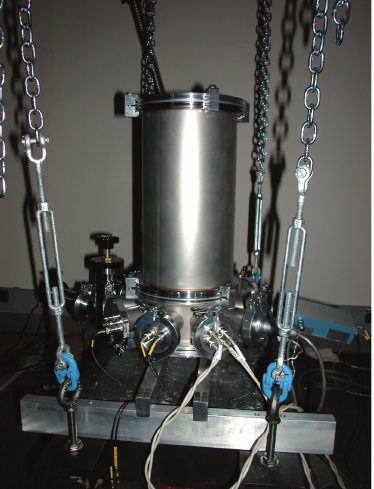
Figure 12: Scanning tunneling microscopy (STM), the same custom STM,butadaptedforroomtemperaturebiologicalapplications,Eric Hudson